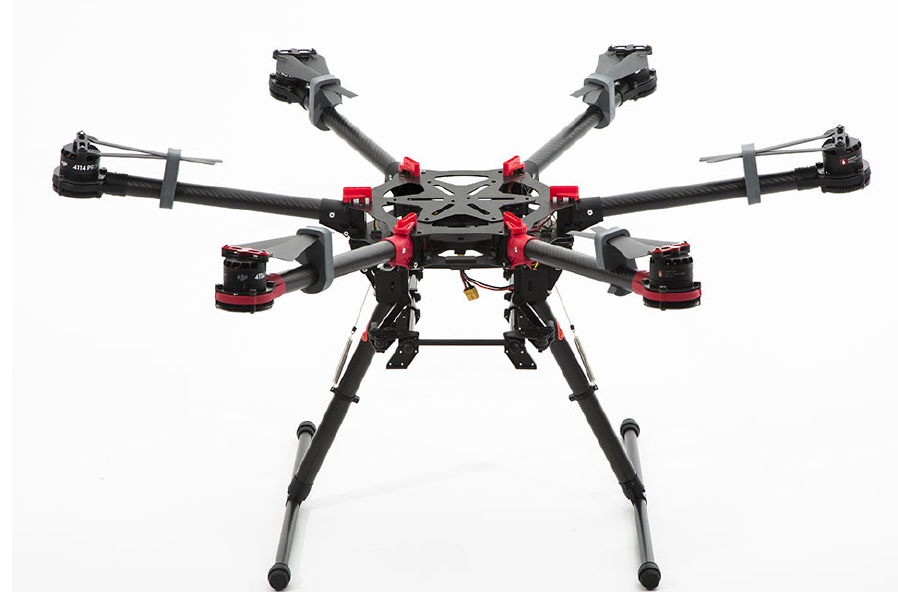
Figure 2. Emergency Support